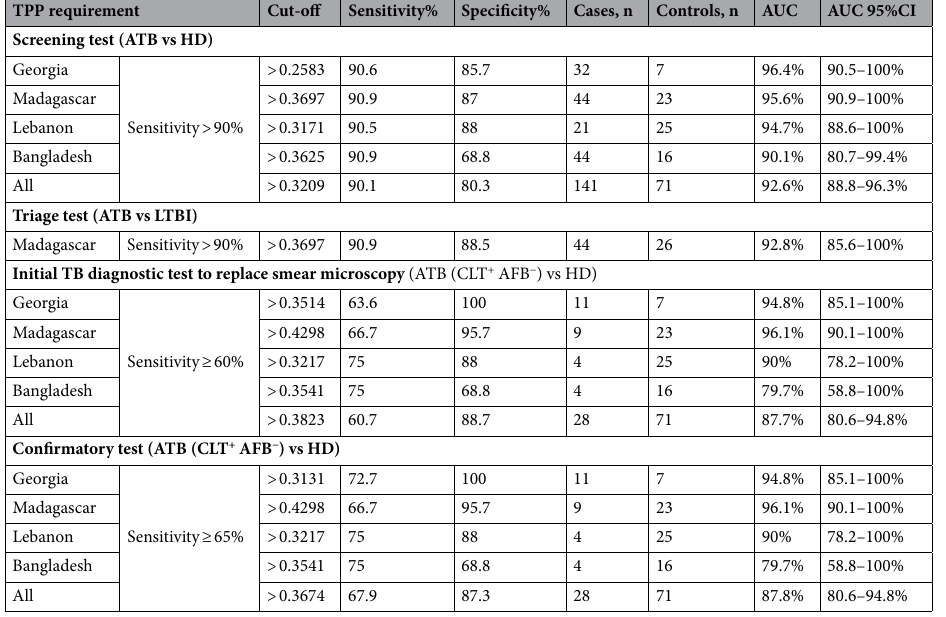
Table 2. Receiver operating characteristic curve analysis of the performance of the RISK6 signature to distinguish active TB cases (ATB) from healthy donors (HD) and from latent TB infected individuals (LTBI) in cohorts from Georgia, Madagascar, Lebanon, and Bangladesh. The performance of the signature is benchmarked against the WHO TPP for a non-sputum based screening/triage test (at a sensitivity of > 90%, the minimum specificity as set out in this TPP should be ≥ 70%), for an initial TB diagnostic test to replace sputum smear (at minimum 60% sensitivity, the minimum specificity as set out in this TPP should be > 98%) and for a confirmatory test (at minimum 65% sensitivity, the minimum specificity as set out in this TPP should be > 98%) 19 . ATB active TB, LTBI latent TB infection (were only recruited from Madagascar), HD healthy donors, CLT + positive sputum culture, AFB − negative AFB smear microscopy, AUC area under the curve, CI confidence interval, Vs versus.